Question: What type of chart is this?
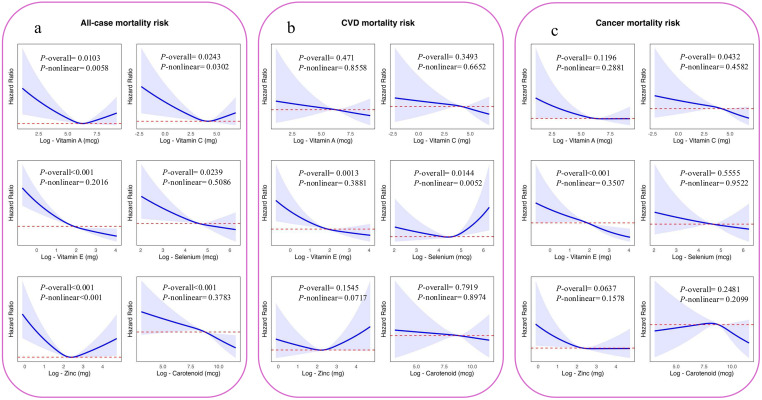
Answer: line